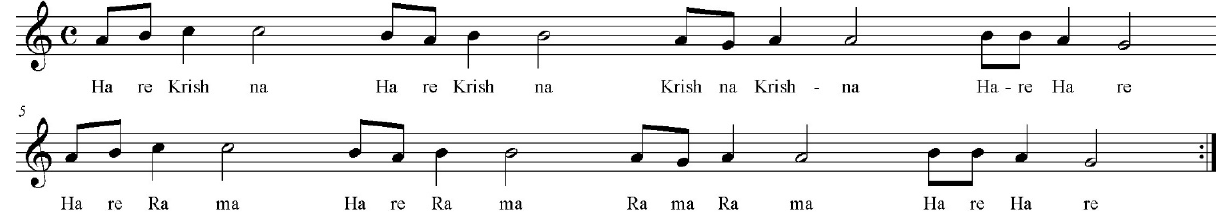
Figure 3. “Hare K ṛṣṇ a Mantra” melody. Figure 3. “Hare Kr.s.n.a Mantra” melody.